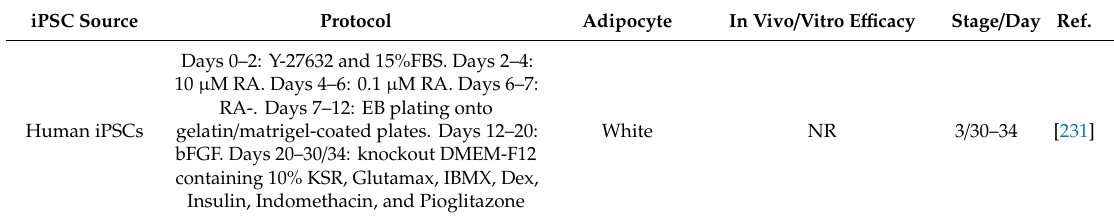
Table 5. Overview of protocols used for di ff erentiation of adipocytes from various sources of iPSCs. iPSC Source Protocol Adipocyte In Vivo / Vitro E ffi cacy Stage / Day